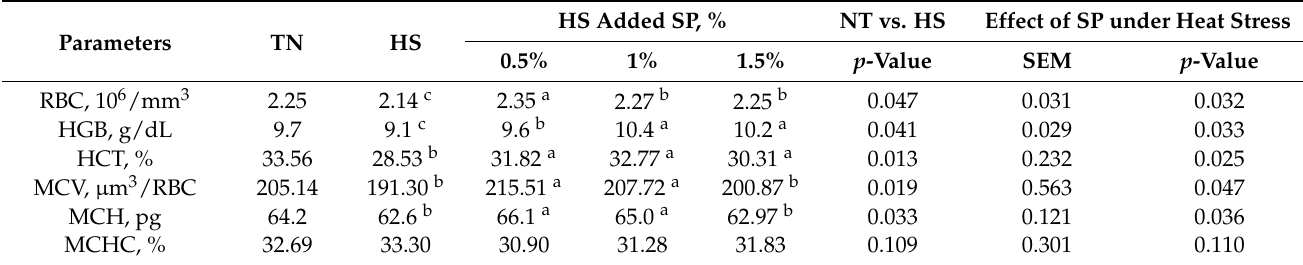
Table 3. Effect of dietary Spirulina platensis supplementation at different levels on hematological parameters of broiler chickens subjected to cyclic heat stress starting from 22 to 42 days of